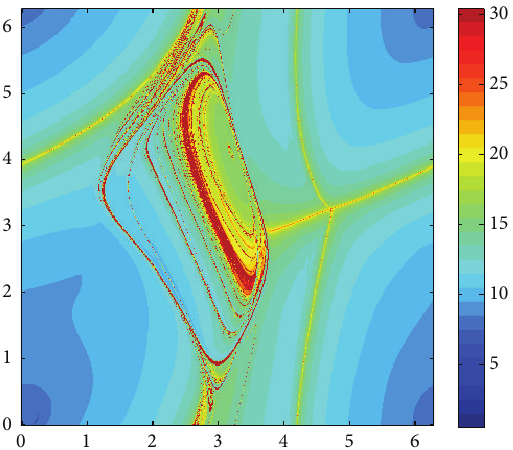
Figure 9: The convergence region and the number of iterations needed for the FDPF method for IEEE 14-bus system on ( 𝜃 2 , 𝜃 3 ) plane.